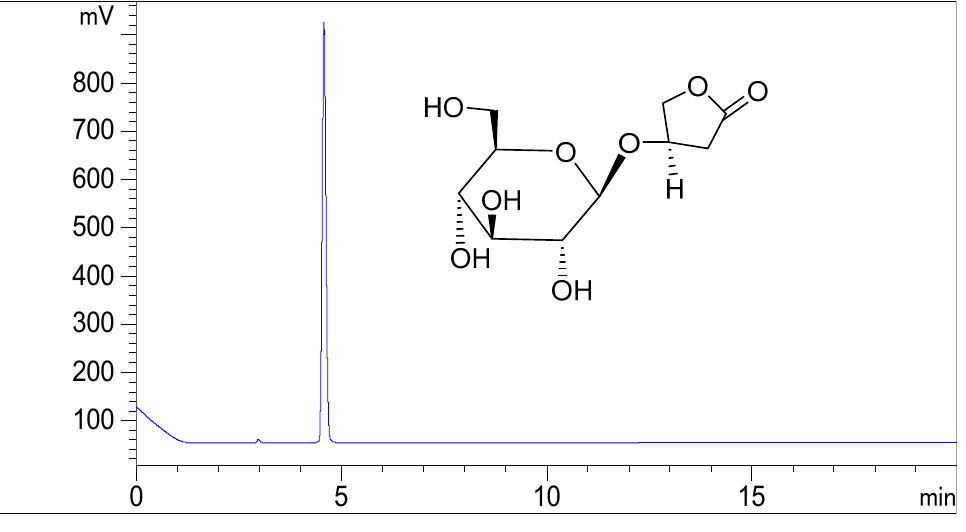
Figure 5. Representative HPLC-ELSD chromatogram of kinsenoside (1 µg mL − 1 ), analyzed by ELSD (evaporation temperature: 70 °C and nebulization temperature: 50 °C), with a C8 column.